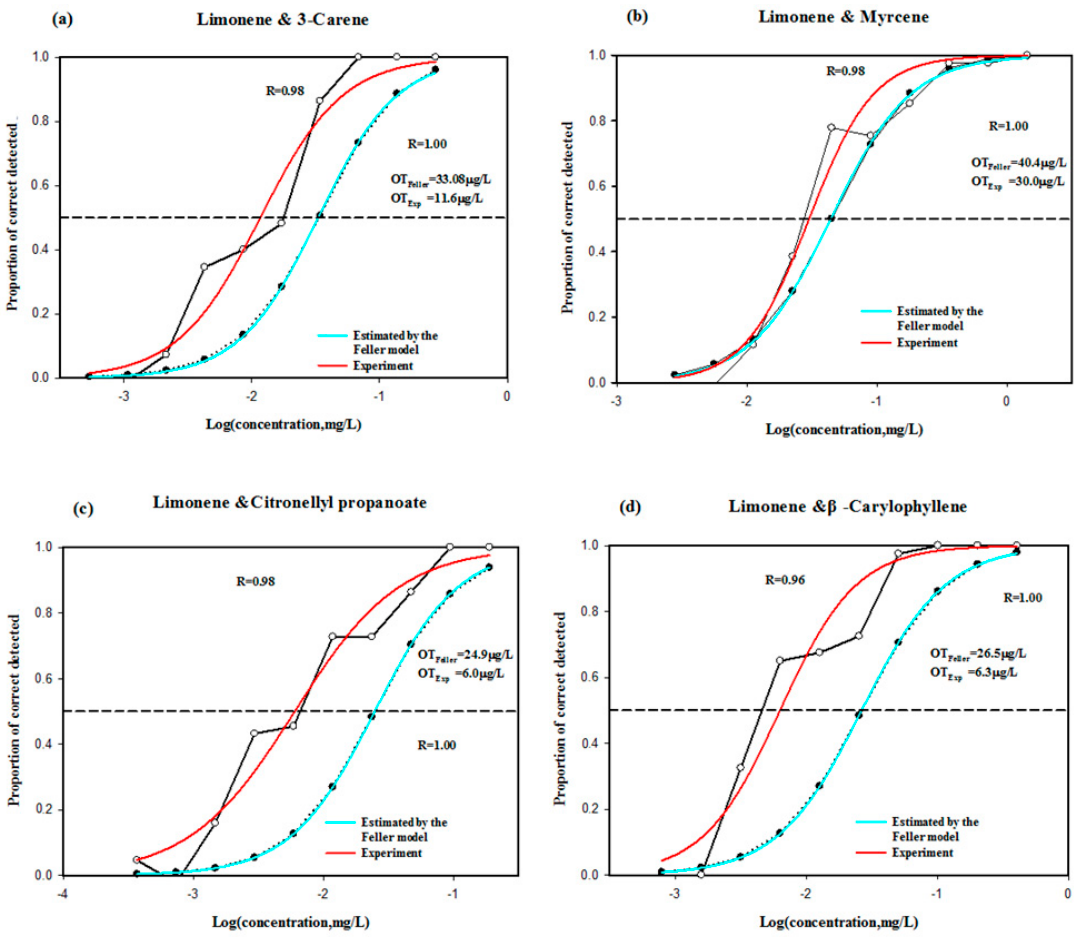
Figure 1. Effect of 3-carene ( a ), Myrcene ( b ), Citronellyl propanoate ( c ), β -caryophyllene ( d ) addition on the detection probability of limonene in a binary mixture. OT, olfactory threshold. The curves are drawn according to a sigmoid function.